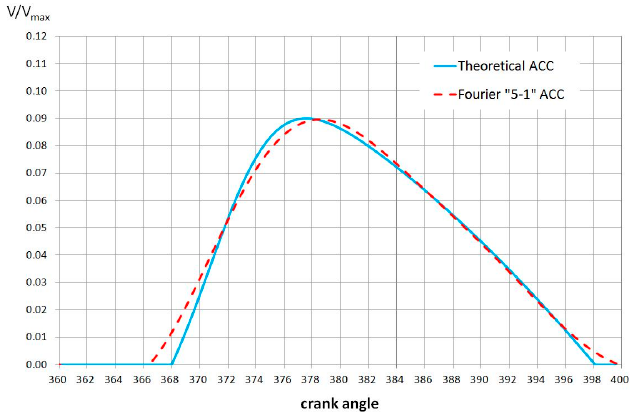
Figure 7. Comparison of volume changes in the complementary system for the rotational speed of 1500 rpm and different stages, respectively: cr = 14:1, cr = 17:1 and cr = 20:1.